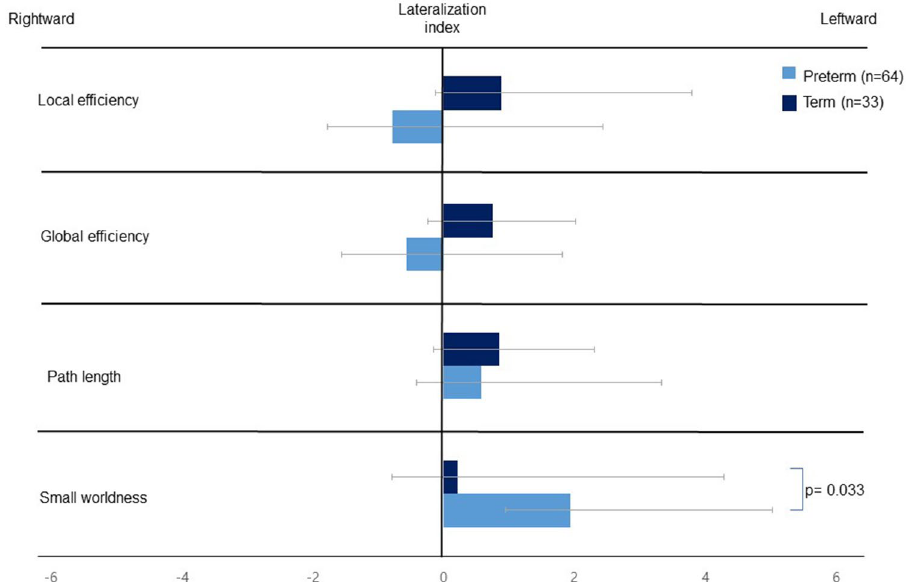
Figure 1. The comparison of the lateralization index of the global network metrics between preterm and full- term infants. We controlled for sex, age at MRI scan, and bronchopulmonary dysplasia when performing the analyses. P values of ≤ 0.05 were considered to indicate statistical significance. All P values were corrected for the false-discovery